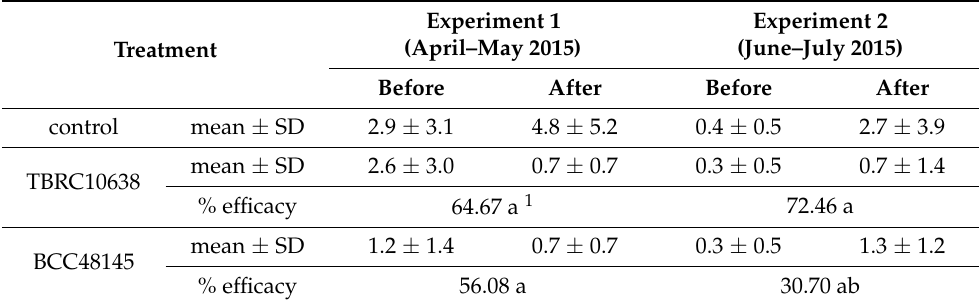
Figure 2. Number of chili thrips ( S. dorsalis ) on chili plants sprayed with P. lilacinum TBRC10638 and B. bassiana BCC48145 in the greenhouse. ( A ). experiment 1 (April–May 2015) and ( B ). experiment 2 (June–July 2015). Table 3. Control efficacy of the fungi B. bassiana BCC48145 and P. lilacinum TBRC10638 against chili thrips ( S. dorsalis ) in the greenhouse